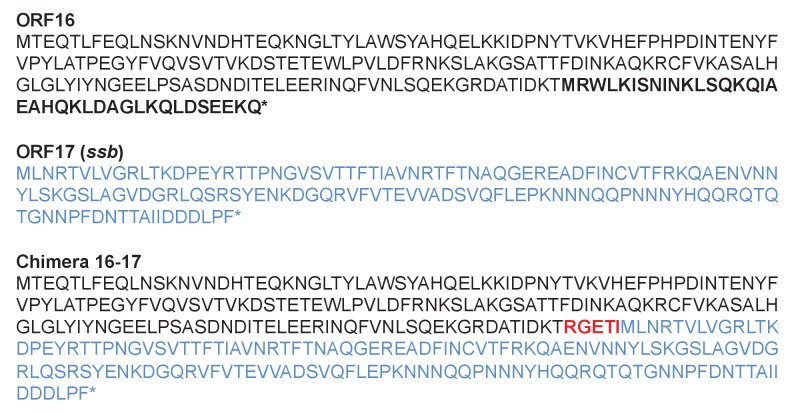
Sequence of the chimeric ORF16-17 protein.Top: sequence of the ORF16 coded protein. The C-terminal part of the protein that is lost in the chimeric protein is highlighted in bold. Middle: Sequence of the Ssb (ORF17) protein. Bottom: Sequence of the chimeric protein. In red is shown the novel sequence generated as a consequence of the mutation, that serves to link the ORF16 and ORF17 encoded proteins.